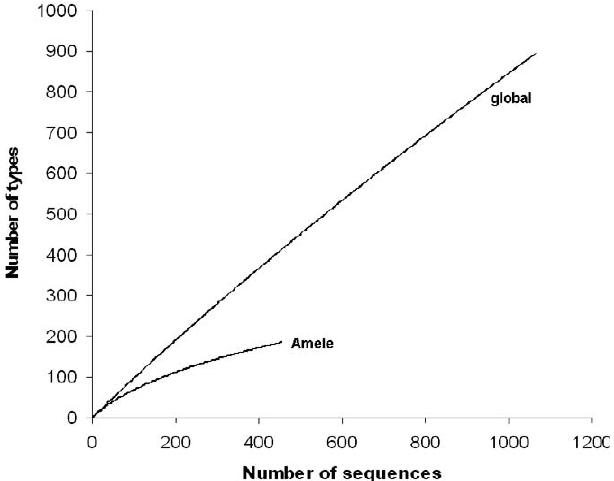
Figure 1. Cumulative Diversity Curves for DBL a from the Amele and Global Populations The cumulative diversity of DBL a was determined by comparing each new DBL a repertoire to previous repertoire(s) using a 96% DNA sequence identity cut-off. We plotted the number of accumulating ‘‘ types ’’ (distinct sequences) against the number of ‘‘ sequences ’’ compared. For example, the first point on the plot will be the number of types found in both isolates A and B on the y-axis against the total number of sequences compared on the x-axis. The next point will be the number of types found in isolates A, B, and C against the total number of sequences compared. The plot shown here is the average curve of 1,000 permutations of the order that isolates were compared (i.e., isolates A, B, then C; or A, C, then B; or B, C, then A).